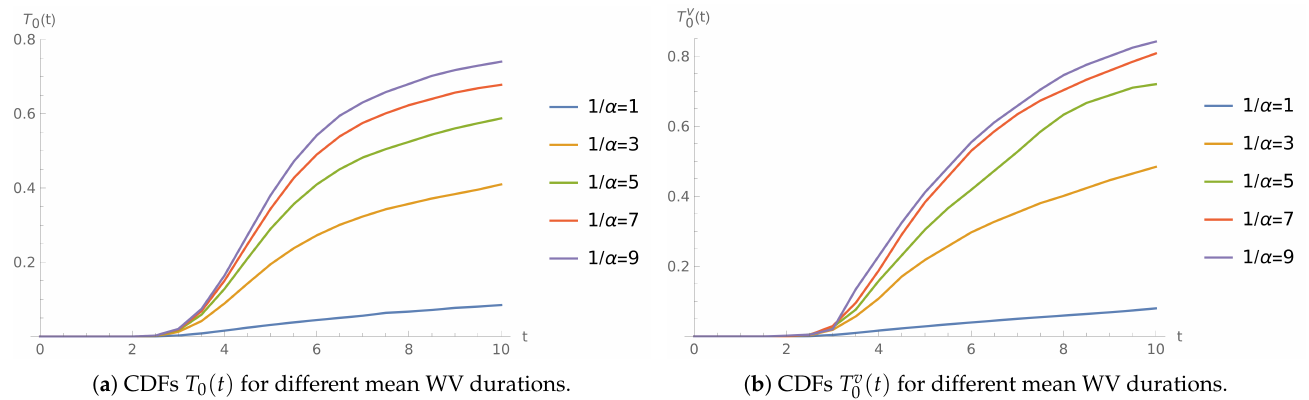
Figure 3. The time to buffer overflow CDFs for µ = 21.